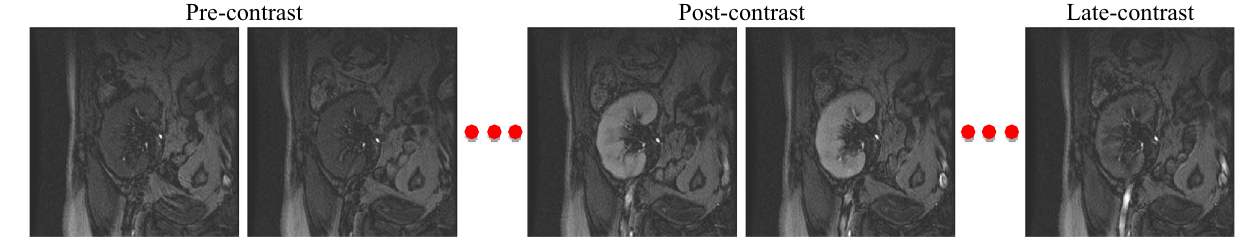
Figure 1. A sequence of DCE-MRI time-point kidney images for one subject manifesting the contrast change caused during the contrast agent perfusion into the